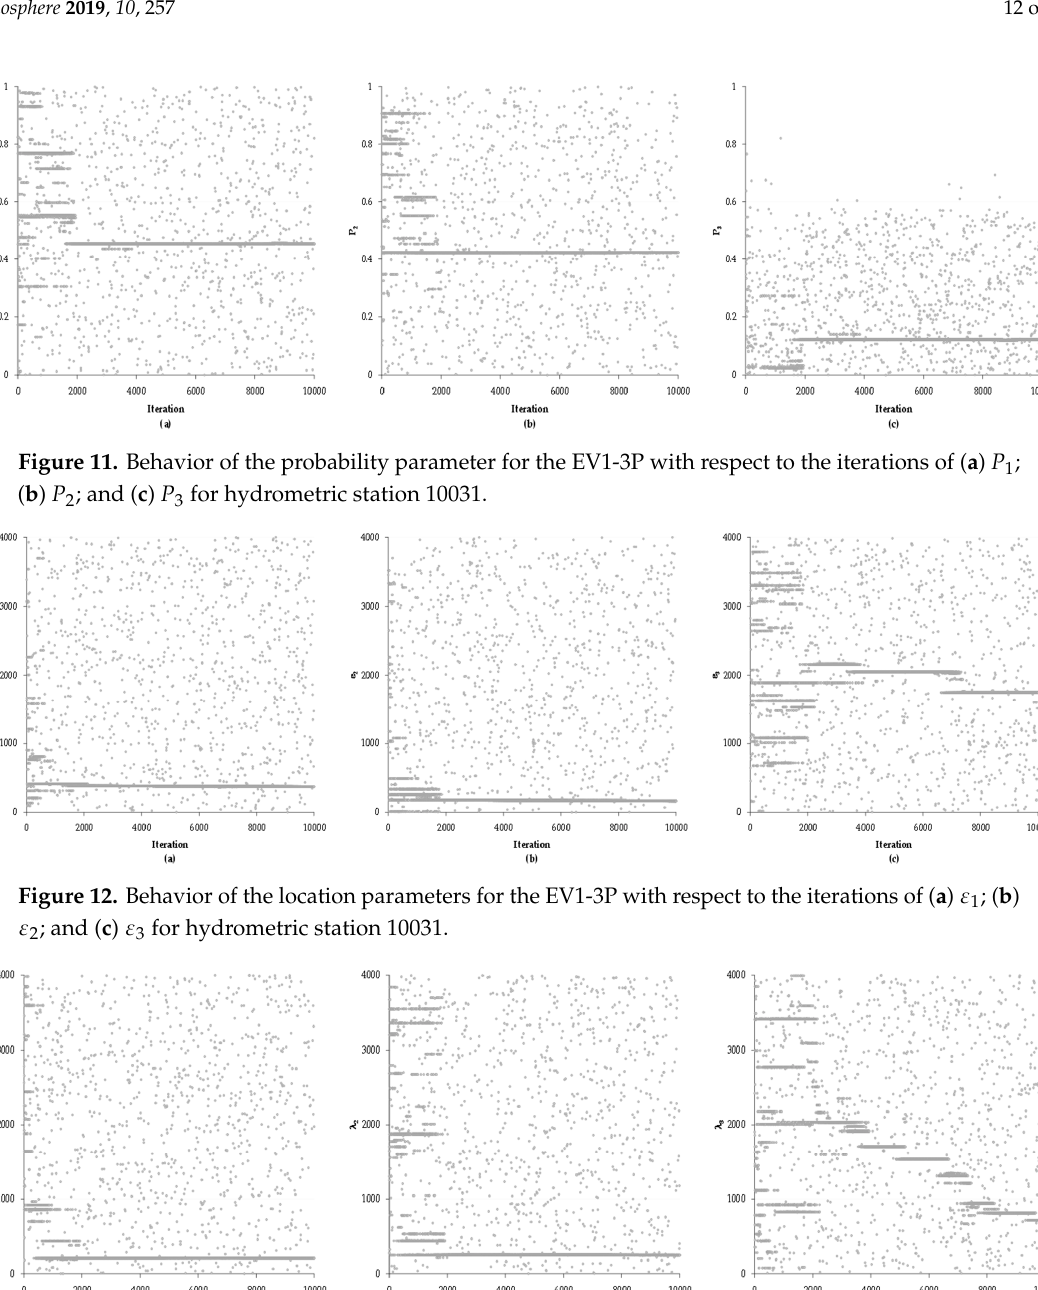
Figure 10. The performance of the HM (40 harmonies) with respect to iterations of the optimization